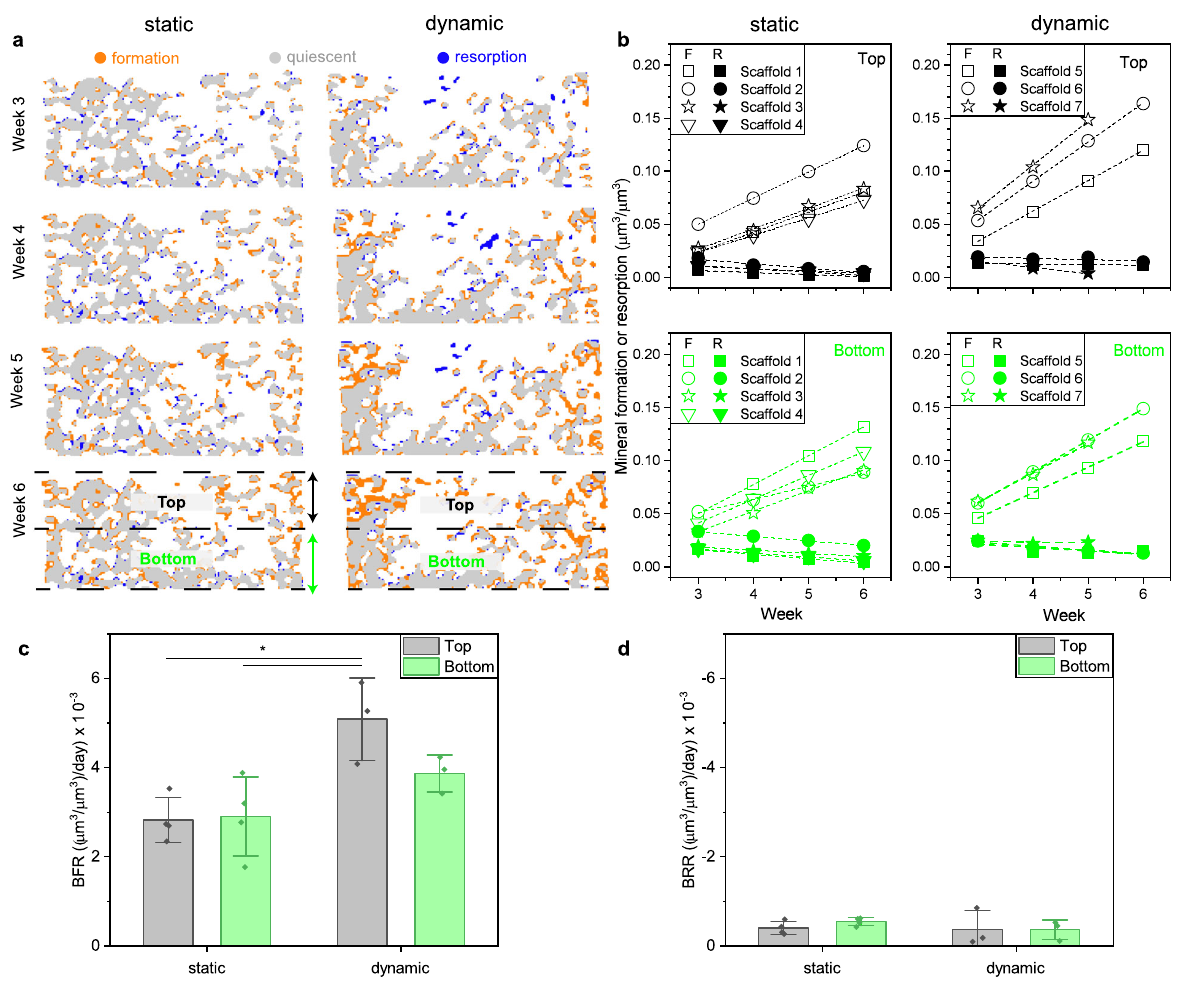
Fig. 4 Micro-CT monitoring, image registration, and local mineral formation analysis of HA55-PLGA (u) scaffolds. a Color-coded vertical cross- sectional images for static and dynamic (5 Hz, 3% strain) cultured scaffolds after 3, 4, 5, and 6 culture weeks. The orange, blue, and gray colors represent mineral formation, resorption, and quiescent volumes, respectively. b Absolute mineral formation (F, open symbols) and resorption (R, fi lled symbols) volumes normalized with the analyzed total volume of 3D images ( a ) as function of time. The total volume was split in a top (black) and bottom (green) region ( a ). c Bone formation rate (BFR) per day obtained from linear fi ts (adj. R 2 = 0.998 ± 0.003, n = 14) of the slopes (open symbols) shown in b ; static ( n = 4), dynamic ( n = 3). d Bone resorption rate (BRR) per day obtained from linear fi ts (adj. R 2 = 0.698 ± 0.43, n = 14) of the slopes ( fi lled symbols) shown in b ; static ( n = 4), dynamic ( n = 3). * p < 0.05; one-way analysis of variance (ANOVA) and Bonferroni post hoc tests. Shapiro – Wilk normality and Levene ’ s test for equality of variances were not signi fi cant. Data are shown as mean ±